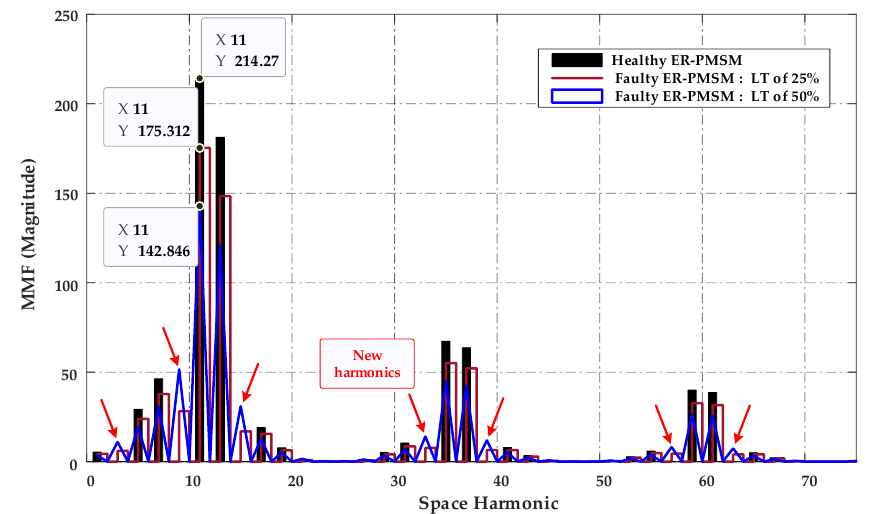
Figure 6. Spatial harmonic spectrum of the total healthy and faulty MMF.